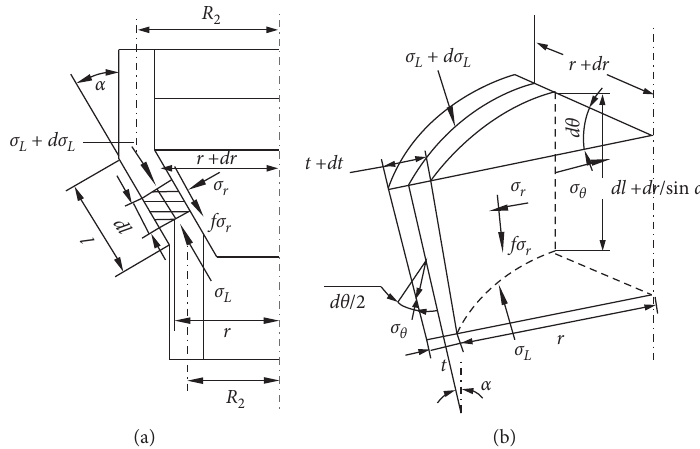
Figure 2: (a) Stress condition of the metal tube and (b) stress state at arbitrary radius ( f : friction coefficient; σ cumferential stress σ r : radial stress; σ s : yield limit; σ d : dynamic yield limit; _ ε strain rate; D , q : constants in Cowper–Symonds